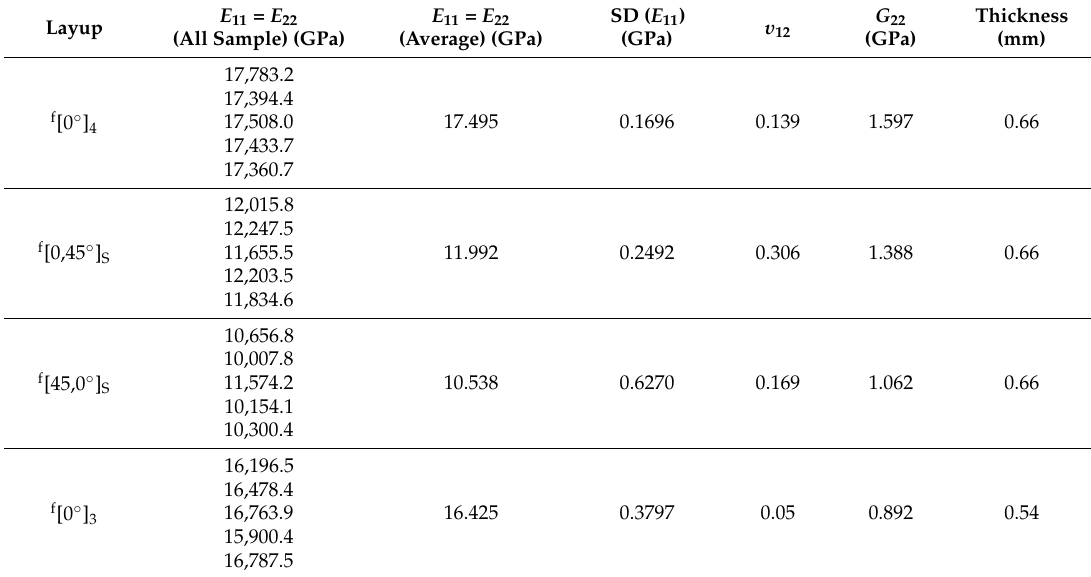
Table 1. Experimentally determined properties of the